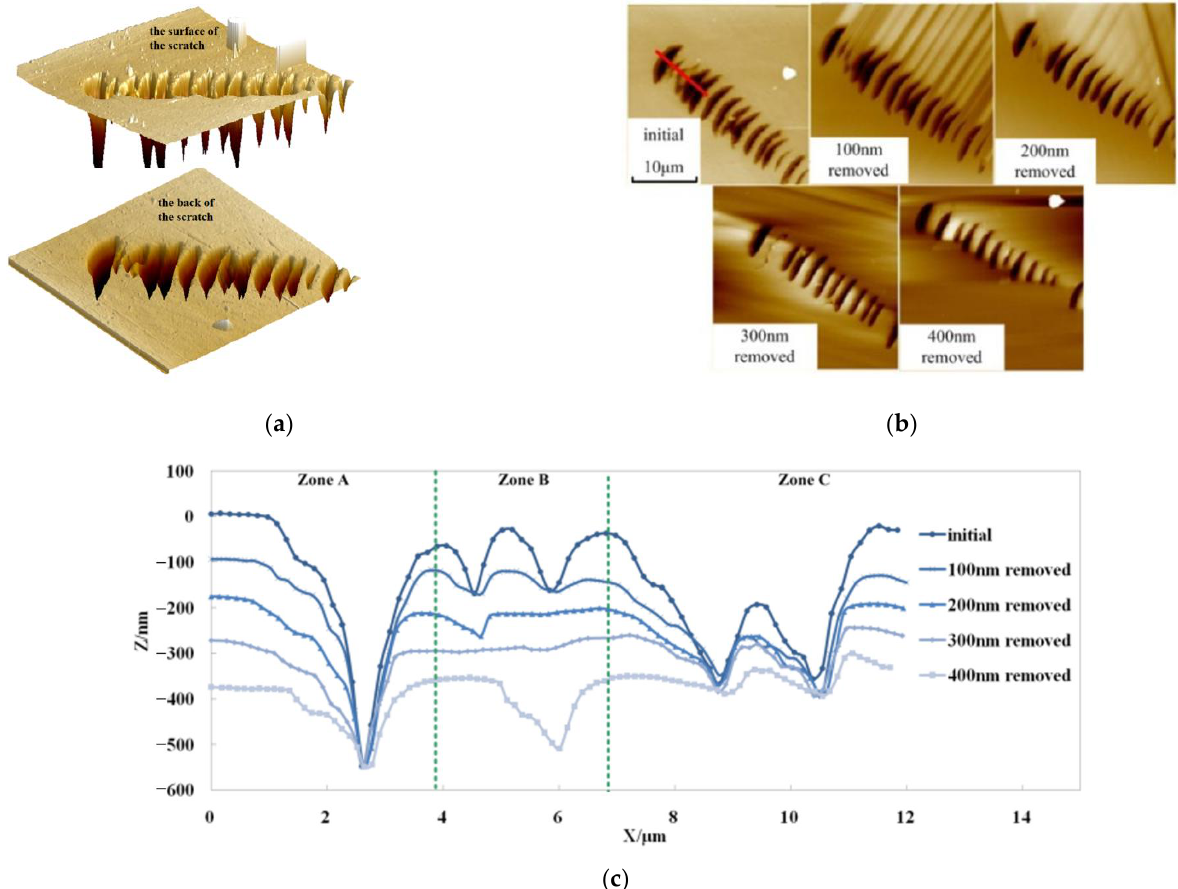
Figure 2. Defect morphology evolution during MRF transformation process. ( a ) 3D AFM picture; ( b ) 2D AFM picture; ( c ) section profile curves of the red line in ( a ).